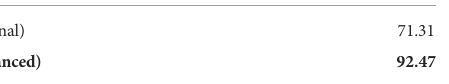
AP: Average Precision. Bold values represent the best indicators in the current